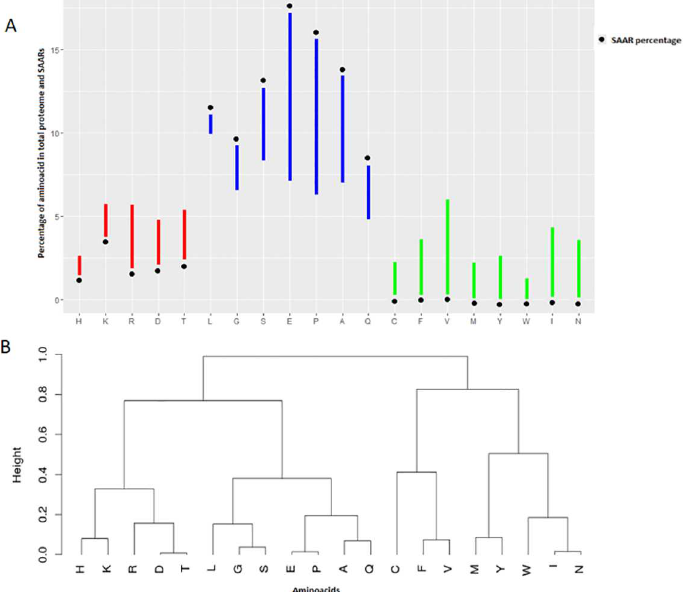
Fig 1. Comparison of amino acid and SAAR density in the human proteome. The amino acid density and SAAR density normalizedto 1 millionresidues were calculatedfor all the 20 amino acids. (A) The percentage of each amino acid in the wholeproteomeand SAARs are represented as vertical bars. The black dot represents the SAAR percentagein each bar and the opposite end indicates amino acid percentage in the wholeproteome. The bars are groupedby colourto indicate the three distinct patterns observed(see text) (blue—group1, red—group2, green—group3) (B) A distance-based dendrogram was plotted for the values of amino acid density and SAAR density for all the 20 amino acids. A distinct pattern of preferencefor SAARs vs. proteomedensity is seen clusteredas three groups as describedin (A) (see text)